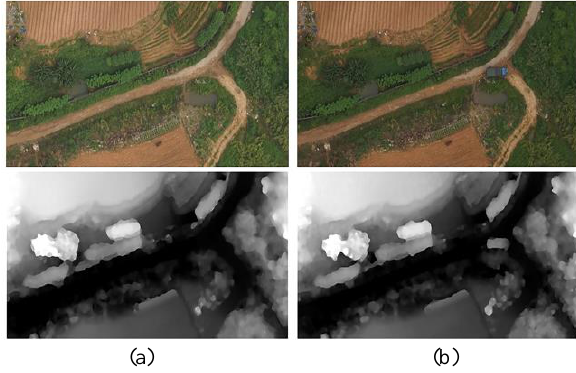
Figure 4. Ortho mapping and DSM data from first-second